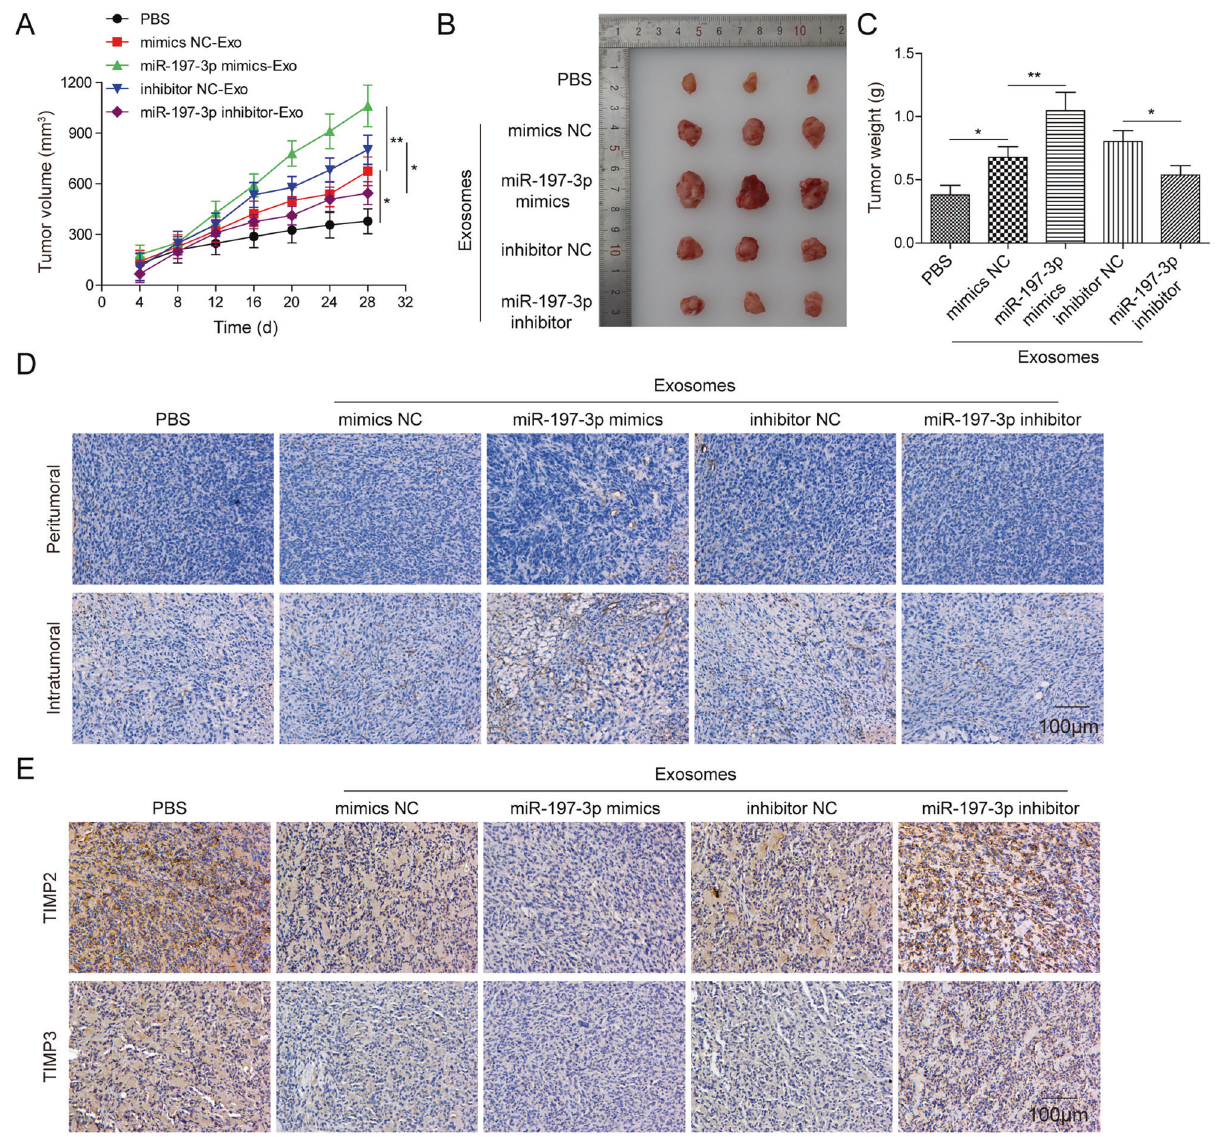
Fig. 4 Exosomal miR-197-3p promotes tumor growth and angiogenesis in vivo. A Tumor volume was measured every 4 days. B Photographs of xenograft tumors. C Tumor weight was measured. D CD31 expression in tumor xenografts was assessed by IHC. E TIMP2 and TIMP3 expression in tumor xenografts were assessed by IHC. Data were representative images or were expressed as the mean ± SD of n = 3 experiments. * P < 0.05, ** P <